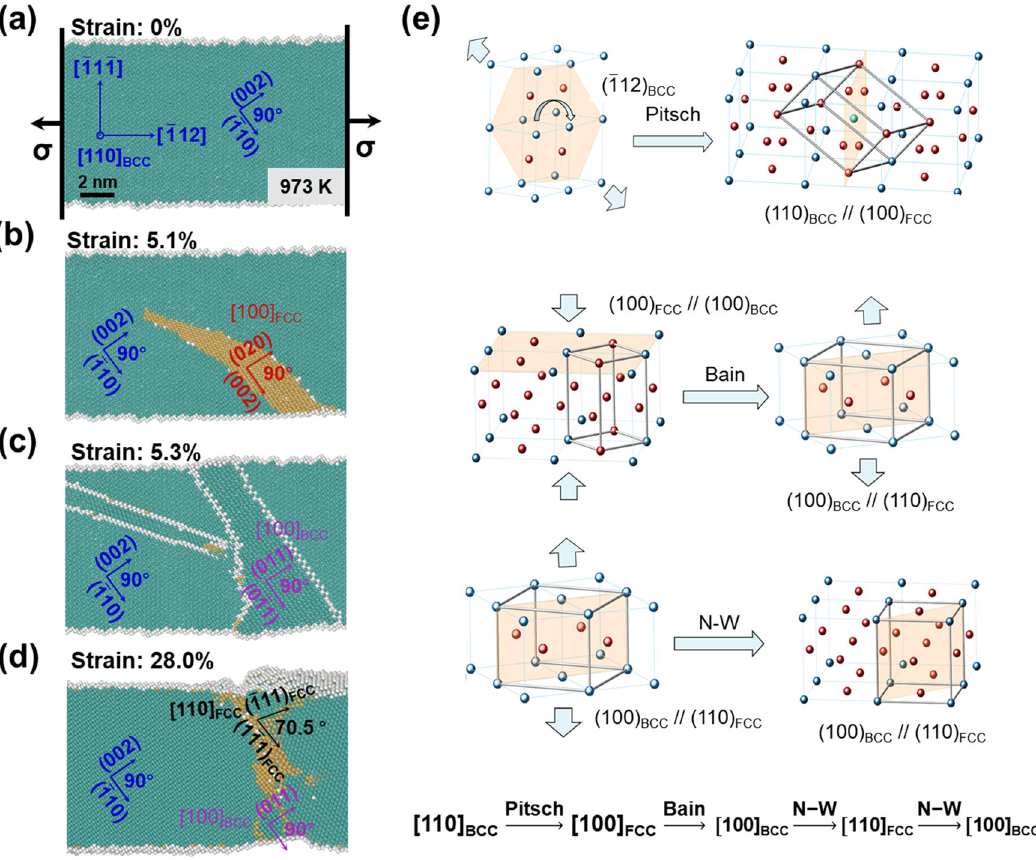
Fig. 4 MD simulation of structural changes of W single crystal at 973 K. a – d Snapshots of the W structure in [110] viewing direction during the process of stretching, demonstrating the transformation process of [110] BCC -[100] FCC -[100] BCC -[110] FCC . e Crystallographic mechanisms of the pathway for the above transformation process. The atoms of the BCC structure are colored green and the atoms of FCC structure are colored yellow. The regions marked by different color basic lattice vectors show different lattice structures, blue: [110] BCC , red: [100] FCC , purple: [100] BCC , black: [110] FCC